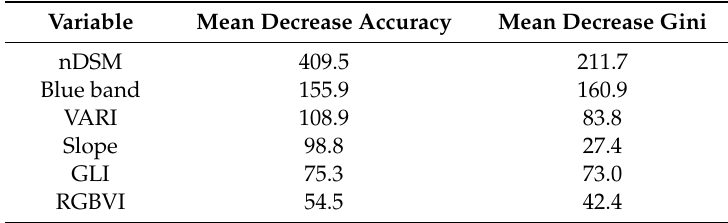
Table 4. Variable importance of the RFE-6 model applied on the ISPRS dataset.